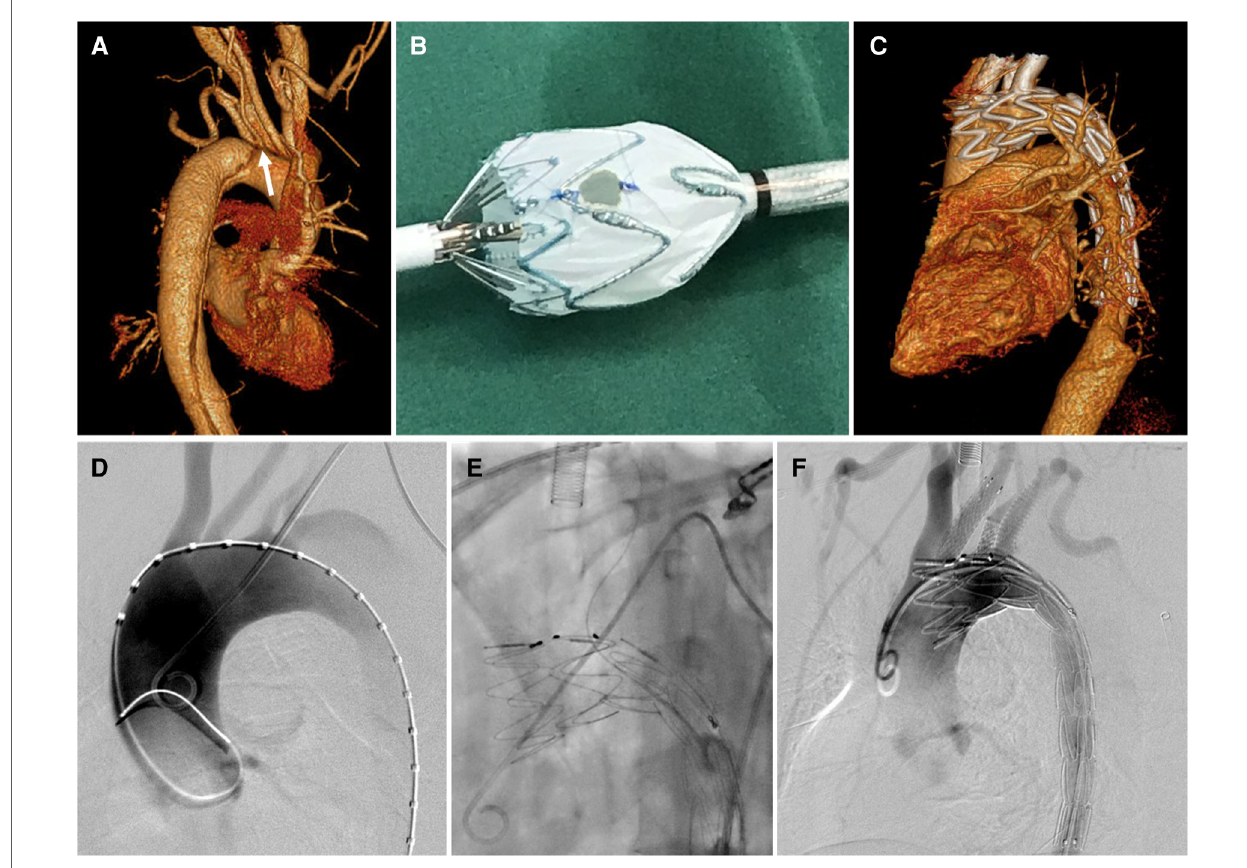
FIGURE 2 Physician modi fi ed-fenestration for isolated left vertebral artery. ( A ) Preoperative CTA of a type B aortic dissection demonstrating the ILVA (white arrow) from the distal aortic arch between the LCCA and the LSA; ( B ) A fenestration was made on the main body stent graft for preservation of ILVA on table; ( C ) follow up CTA showed patent target vessels and well excluded aortic dissection without endoleak; ( D ) intraoperative aortography showed a type B aortic dissection with a ILVA; ( E ) After full deployment of the stent graft, the ILVA was super-selected from the contralateral femoral access followed by bridging stent implantation; ( F ) Final aortography demonstrated complete exclusion of aortic dissection and patent aortic arch branch arteries, with bridging stent- grafts in the LCCA, ILVA, and